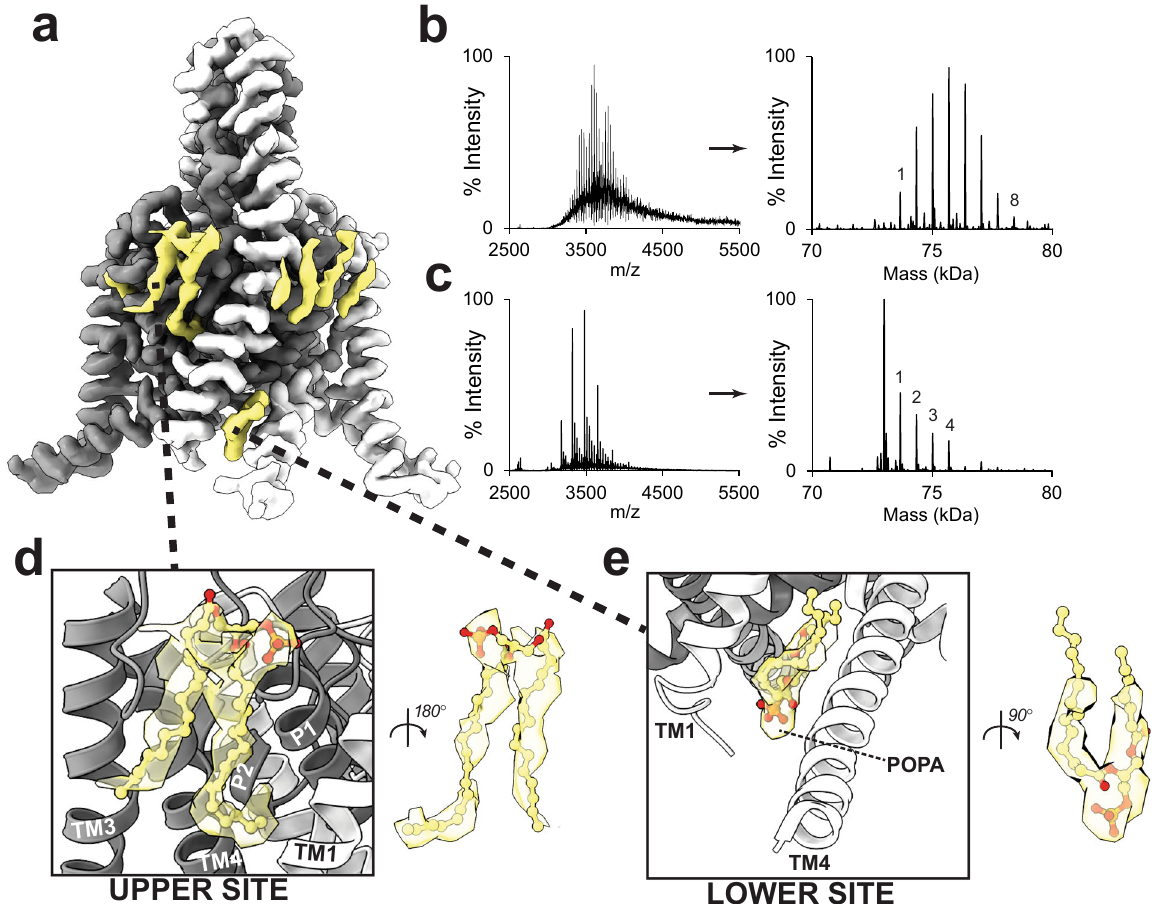
Fig. 3 | Identi fi cation of POPA lipid binding sites in the TREK1 channel struc- ture. Cryo-EM density map of TREK1 solubilized in DDM detergent supplemented with POPA lipids ( a ), highlighting locations of bound POPA molecules (yellow). ( b ) Native mass spectrum of TREK1 dimer with POPA (left), and deconvoluted spec- trum(right)showingmultiplepeakscorrespondingtoTREK1dimerwithuptoeight bound POPA molecules (numbers above peaks indicate the number of bound POPA).UndermoreactivatingMSconditions( c ),thenumberofboundPOPAlipids